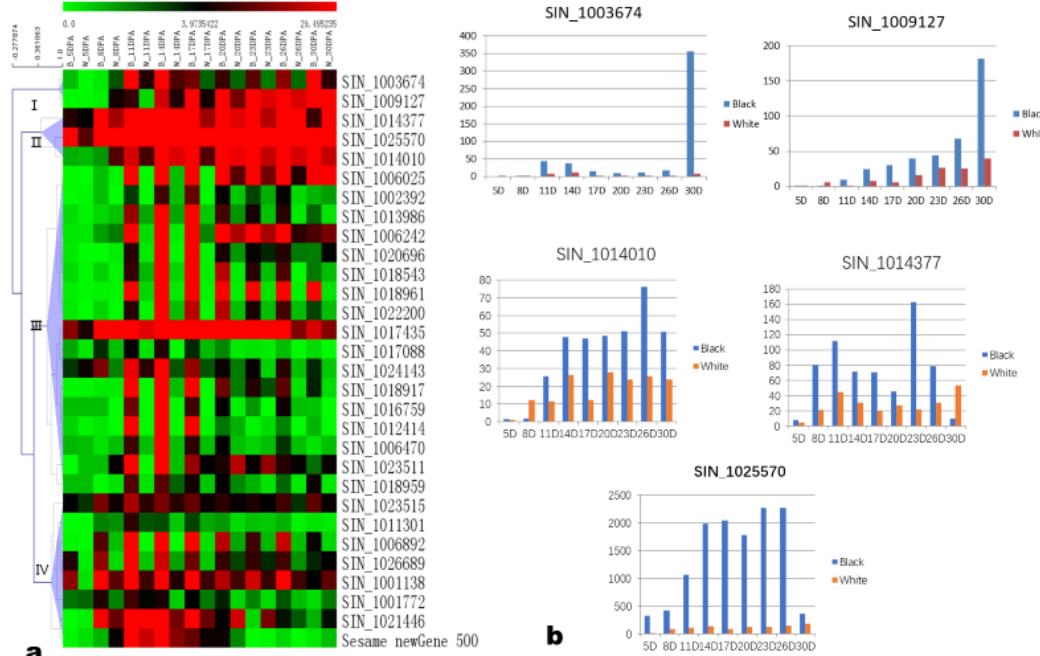
Figure 7. Hierarchical clustering and expression profiles of the 5 DEGs in black and white sesame. ( a ) Hierarchical clustering of the 30 DEGs. ( b ) Expression profiles of subgroup 1 and 2 genes in black and white sesame (only SIN_1025570 was included in the candidate genes list).